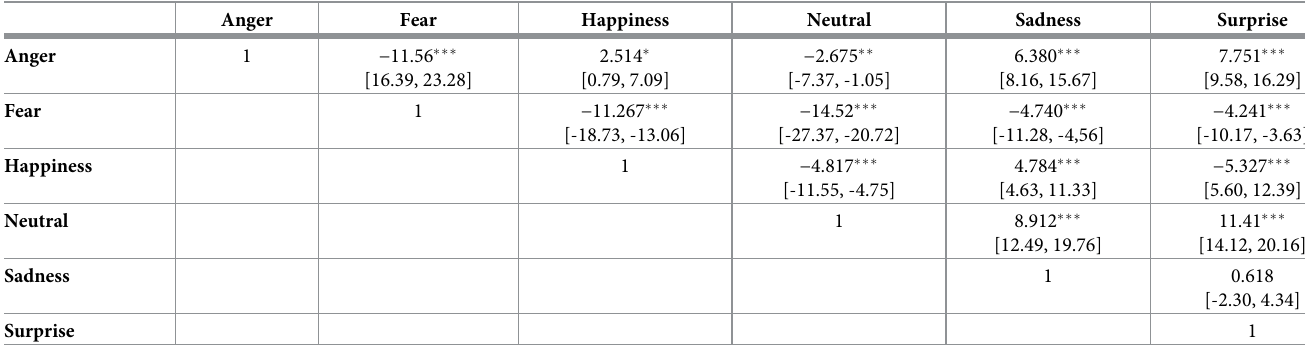
Table 19. Pairwise comparisons for Phase 2 emotions.